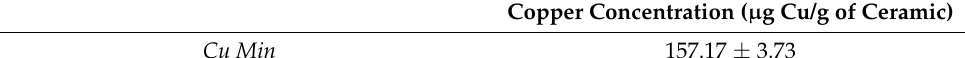
Table 1. Copper concentration ( µ g Cu/g of ceramic) in Cu Min , Int and Max samples, determined by